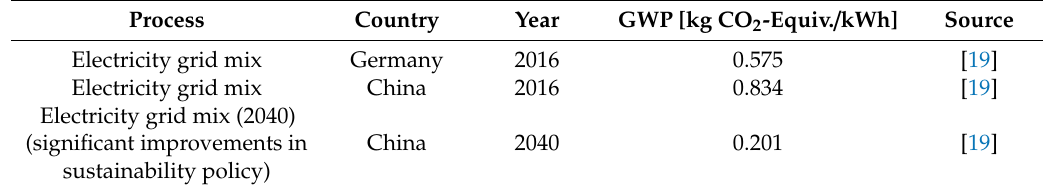
Table A1. Global Warming Potential of the used electricity grid mixes for Germany and